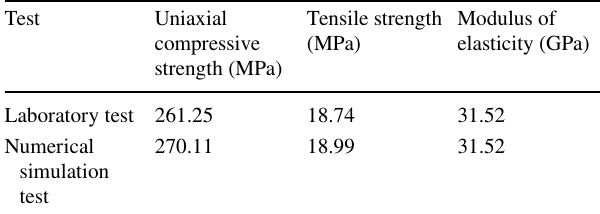
Table 4 Values of microscopic parameters of smooth joint model